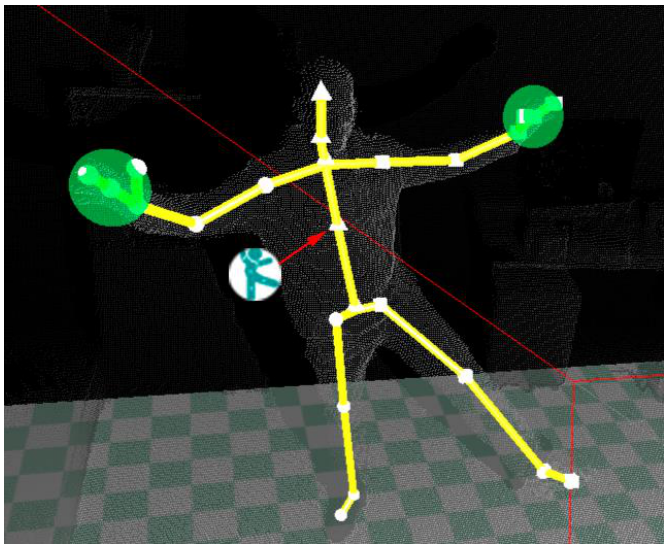
Figure 8. The mark (a circle enclosing the system logo) is placed on the position estimated for the SPINE_MID joint, which is located around the thoracic T5